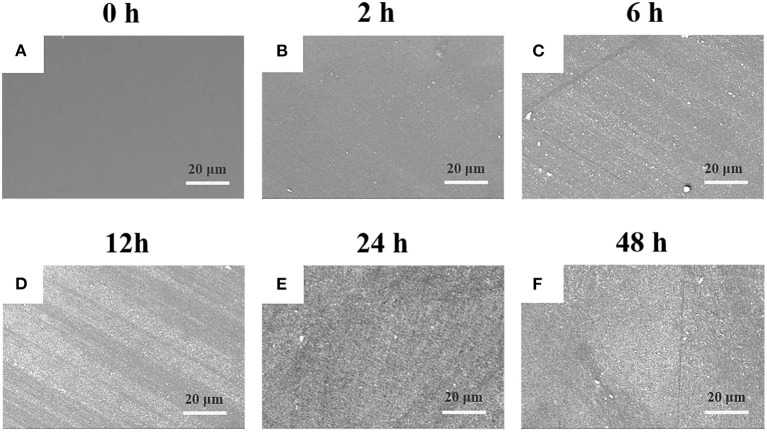
SEM images of plasma-treated PEEK coating with PDA film for (A) 0, (B) 2, (C) 6, (D) 12, (E) 24, and (F) 48 h.